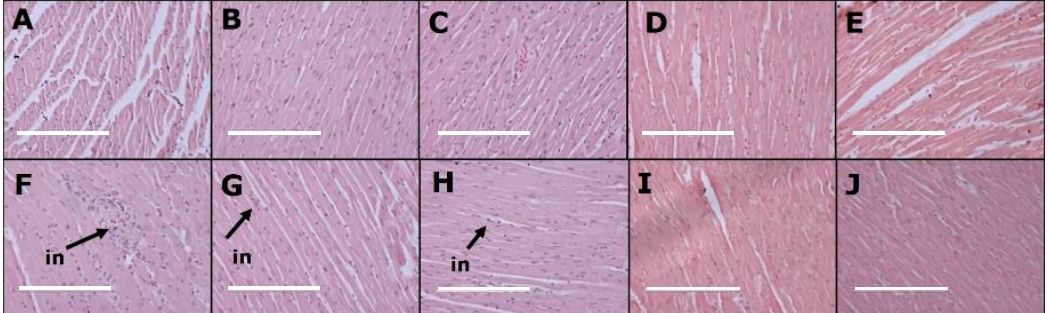
Figure 1. Effects of curcumin on inflammatory cells (“in”) in the heart using haematoxylin and eosin stain in corn starch diet-fed rats ( A ), corn starch diet-fed rats given 5 mg / kg / day curcumin ( B ), corn starch diet-fed rats given 100 mg / kg / day curcumin ( C ), corn starch diet-fed rats given 5 mg / kg / day curcumin nanoparticles ( D ), corn starch diet-fed rats given blank nanoparticles ( E ), high-carbohydrate, high-fat diet-fed rats ( F ), high-carbohydrate, high-fat diet-fed rats given 5 mg / kg / day curcumin ( G ), high-carbohydrate, high-fat diet-fed rats given 100 mg / kg / day curcumin ( H ), high-carbohydrate, high-fat diet-fed rats given 5 mg / kg / day curcumin nanoparticles ( I ) and high-carbohydrate,